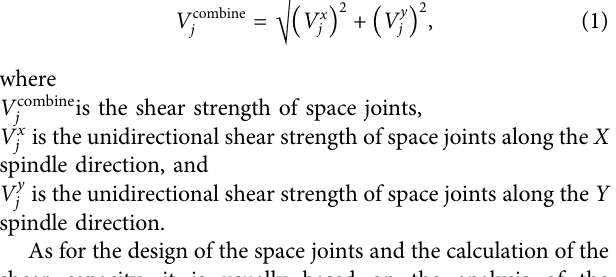
FIGURE 7 | Reinforcement of the beam section of specimen